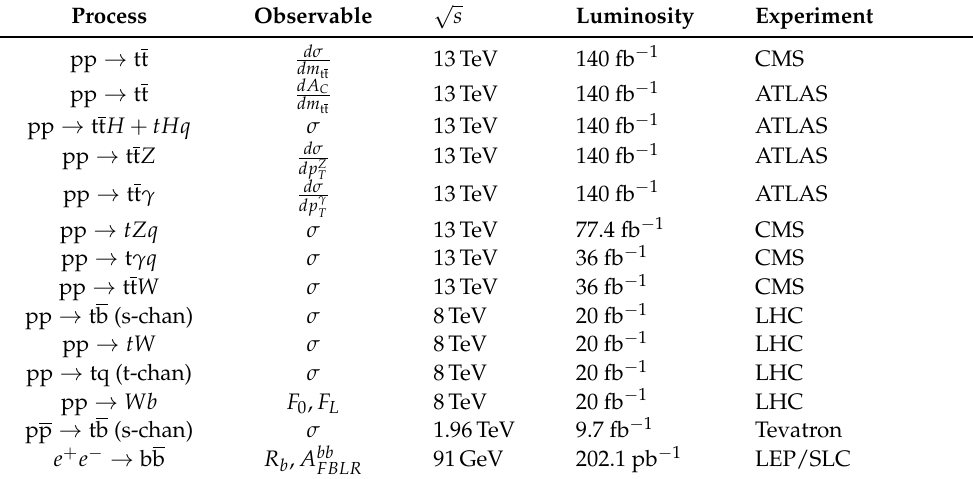
Table 3. Measurements included in the top-quark EW sector EFT fit [59]. The table includes the pro- cess, observable, centre-of-mass energy, integrated luminosity and experiment for each measurement. Where the experiment is cited as LHC, a combination of ATLAS and CMS measurements were used. Where Tevatron is cited, a combination of CDF and D0 results were used. LEP/SLD refers to different experiments from these two